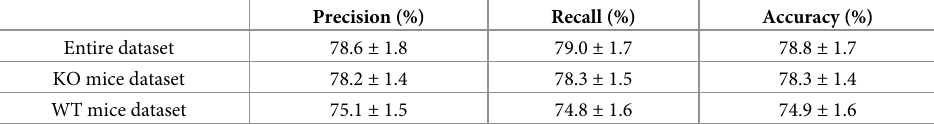
Table 1. Test set classification results of CNN architecture considering the entire dataset and the two genotype- based datasets, evaluated in terms of precision, recall and accuracy